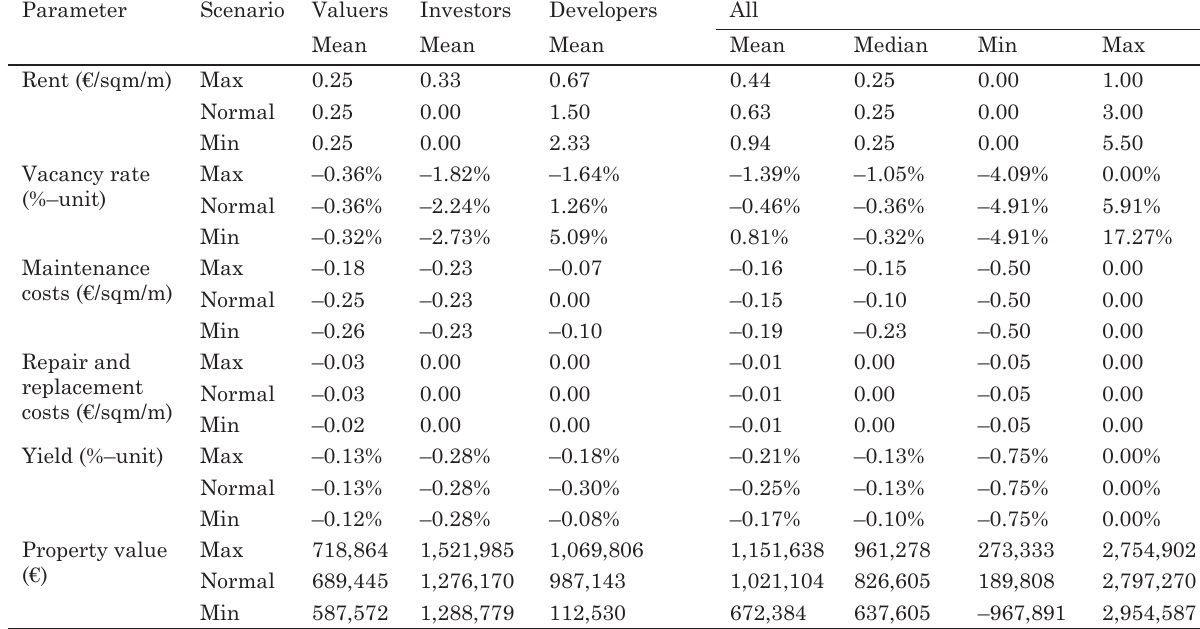
Table 3. Summary of the differences in the DCF parameters between non–certified and certified properties Parameter